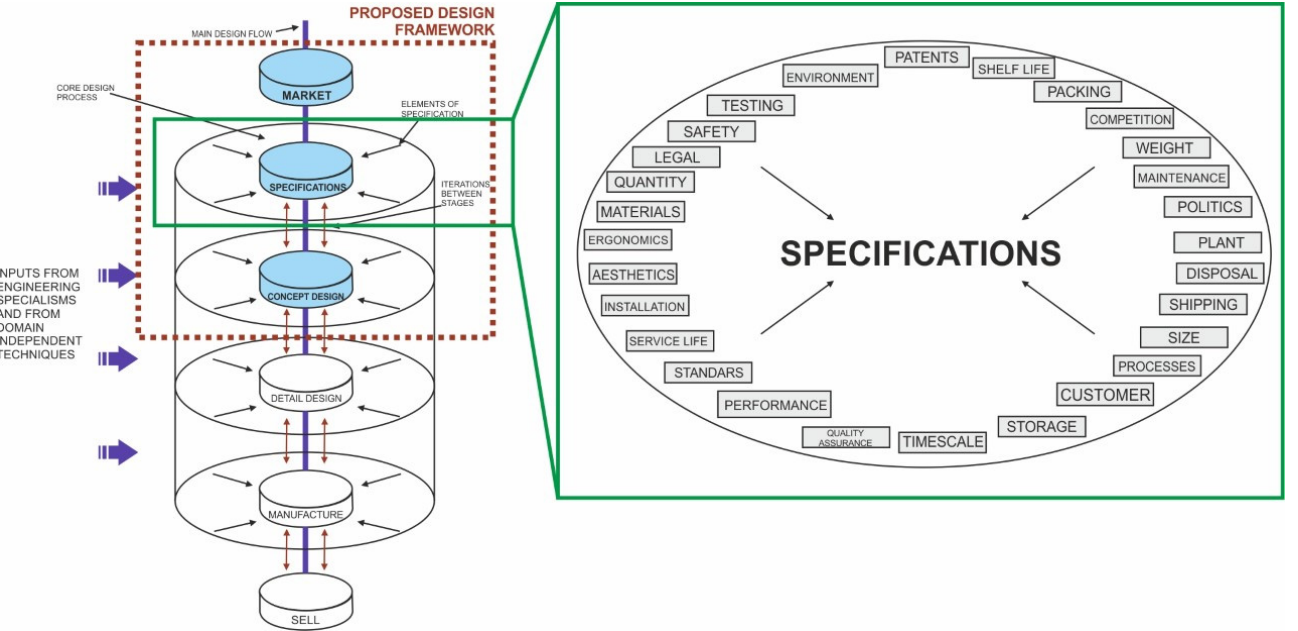
Figure 3. Product design specifications (PDS) of Pugh’s Total Design model. Based on [34].